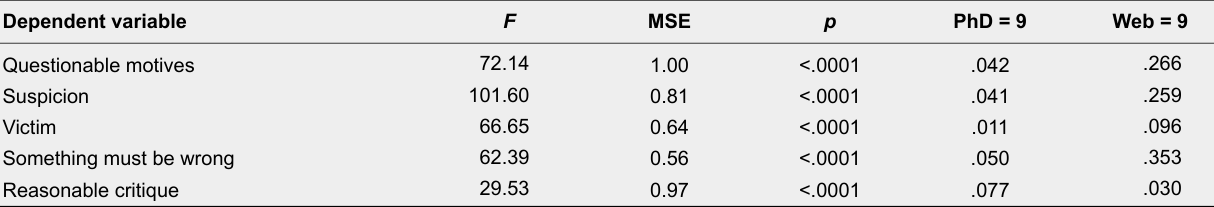
Summary of Results for Study 3